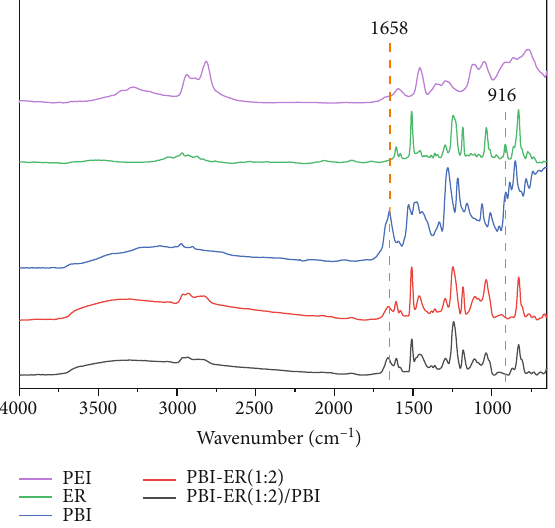
Figure 2: FT-IR spectra of PEI, ER, and PBI membranes, PEI- ER(1 :2) membrane, and PEI-ER(1:2)/PBI semi-IPN